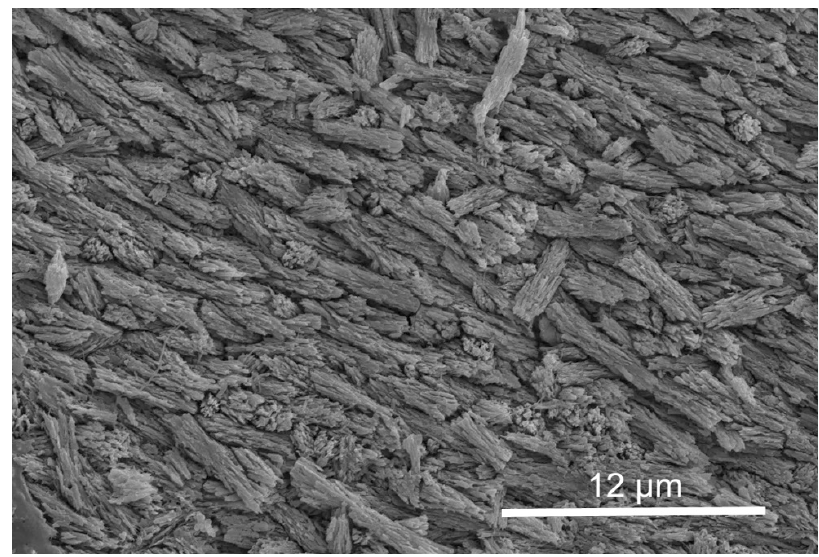
Figure 6. The transverse section of ASOIOP structure in Protula diomedea .